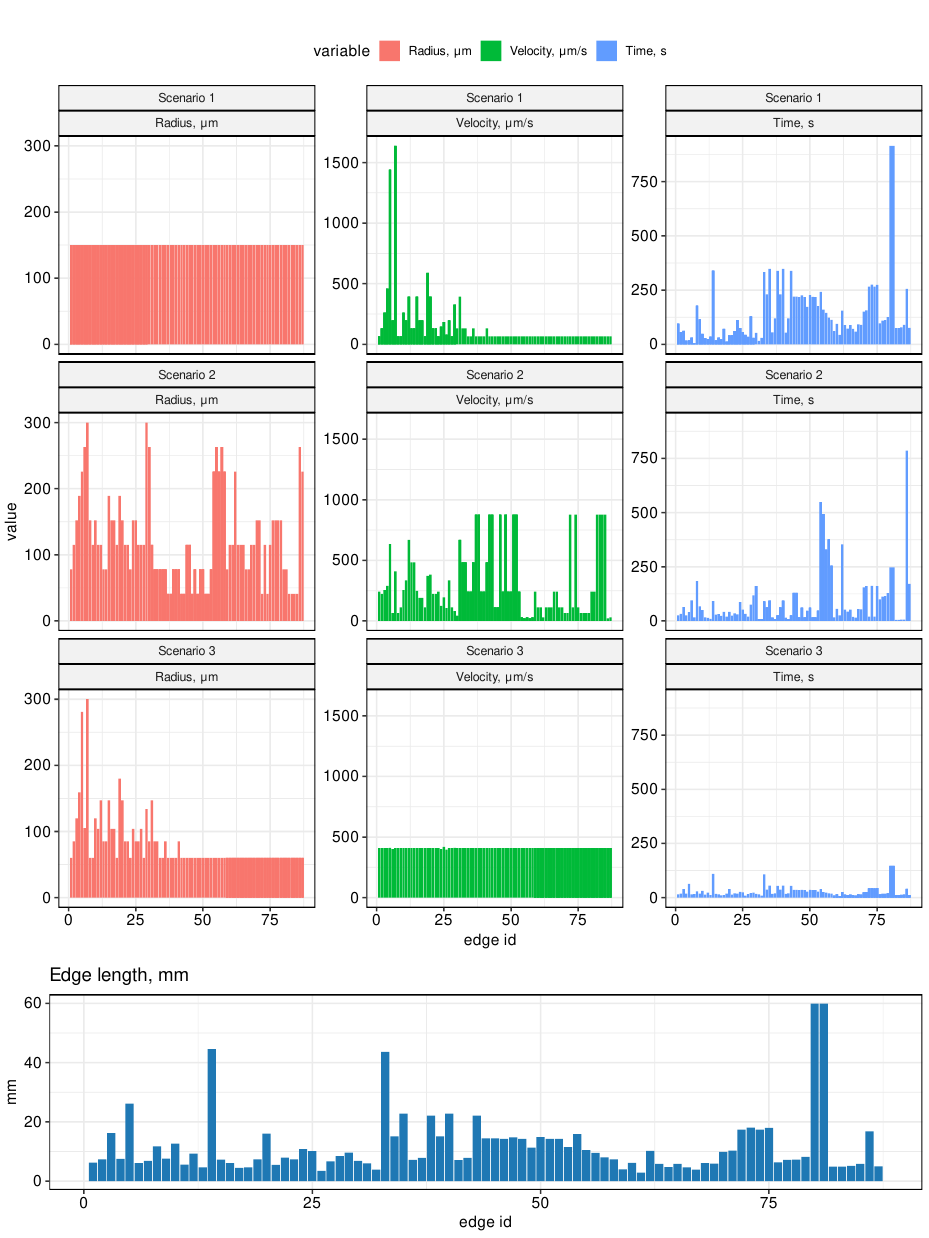
Figure 4. The distribution of the velocities and transient transfer times of lymph flow in the vessels for the three scenarios of vessel radii distribution. At the bottom, the distribution of the edge lengths is shown, which is the same for all